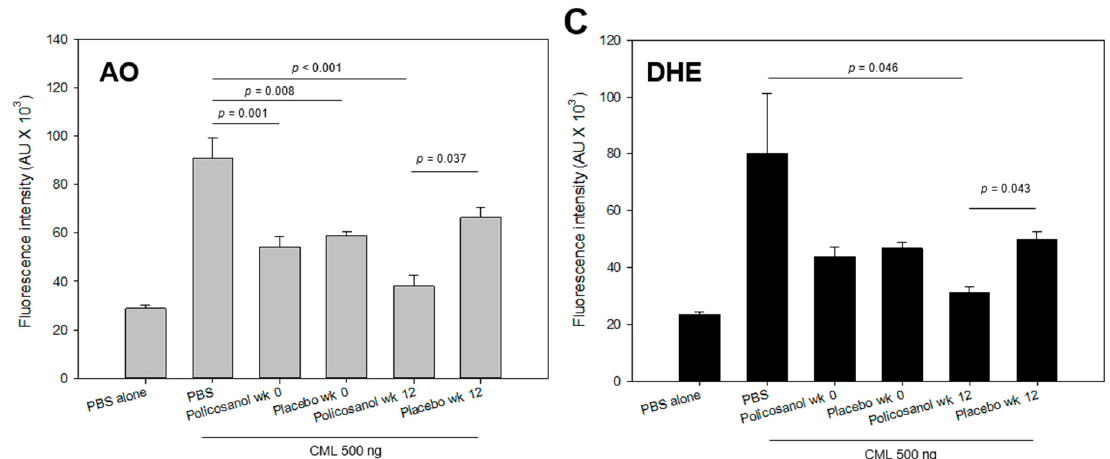
Figure 8. Comparison of the protective activity of HDL 2 (1 mg/mL) from the policosanol and placebo groups against carboxymethyllysine (CML, final 500 ng) toxicity in zebrafish embryos. ( A ) Survivability of zebrafish embryos during 24 h post-injection in the presence of HDL 2 (20 ng) and CML. Embryo numbers were adjusted from three independent experiments. The data are expressed as the mean ± SD from five independent experiments. Statistically significant differences in multiple groups were compared using a one-way analysis of variance (ANOVA). *, p < 0.05 between the policosanol group at weeks 0 and 12; **, p < 0.005 between the policosanol group at week 12 and CML alone; #, p < 0.05 between the placebo group at week 12 and CML alone. ( B ) Stereo image of the zebrafish embryos at 5 and 24 h post-injection. The red arrowheads indicate defective development and death of embryos in the CML group (photographs b, c, d, and f). The blue arrowhead indicates the slowest developmental speed in eye pigmentation and tail elongation in the CML group at 24 h post injection (photographs b, c, d, and f). Fluorescence image of dihydroethidium (DHE, Ex = 585 nm, Em = 615 nm) stained and acridine orange (AO, Ex = 505 nm, Em = 535 nm) stained embryo at 5 h post-injection. The extent of ROS production and apoptosis was visualized by DHE and AO staining, respectively. ( C ) Quantification of the fluorescence from DHE-stained and AO-stained embryo images using Image J software (http://rsb.info.nih.gov/ij/, accessed on 3 January 2023). The data are expressed as the mean ± SD from five independent experiments. The statistical differences of multiple groups were compared using a one-way analysis of variance (ANOVA). AU, arbitrary unit.